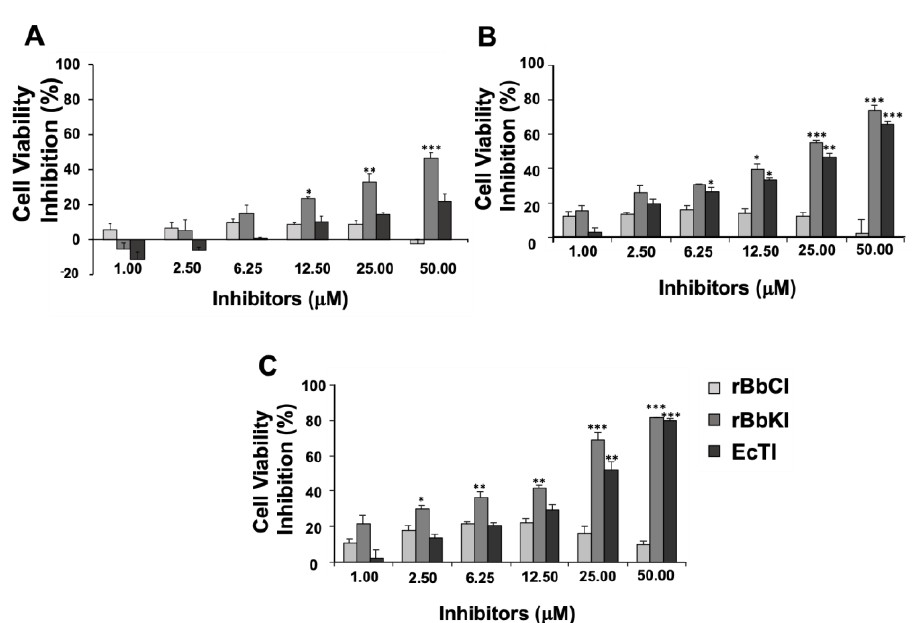
Figure 1. Action of rBbCI, rBbKI, and EcTI on the cell viability of L929 cells. L929 cells were pre-incubated for 24 h, increasing concentrations of rBbCI, rBbKI, and EcTI were added to the 96-well plates, and cells were analyzed after incubation for ( A ) 24 h, ( B ) 48 h, ( C ), or 72 h. Each bar represents the mean ± standard deviations of three repetitions. (* p <0.05, ** p <0.005, *** p <0.0001; One way-ANOVA, follow Tukey’s Multiple Comparison Test).